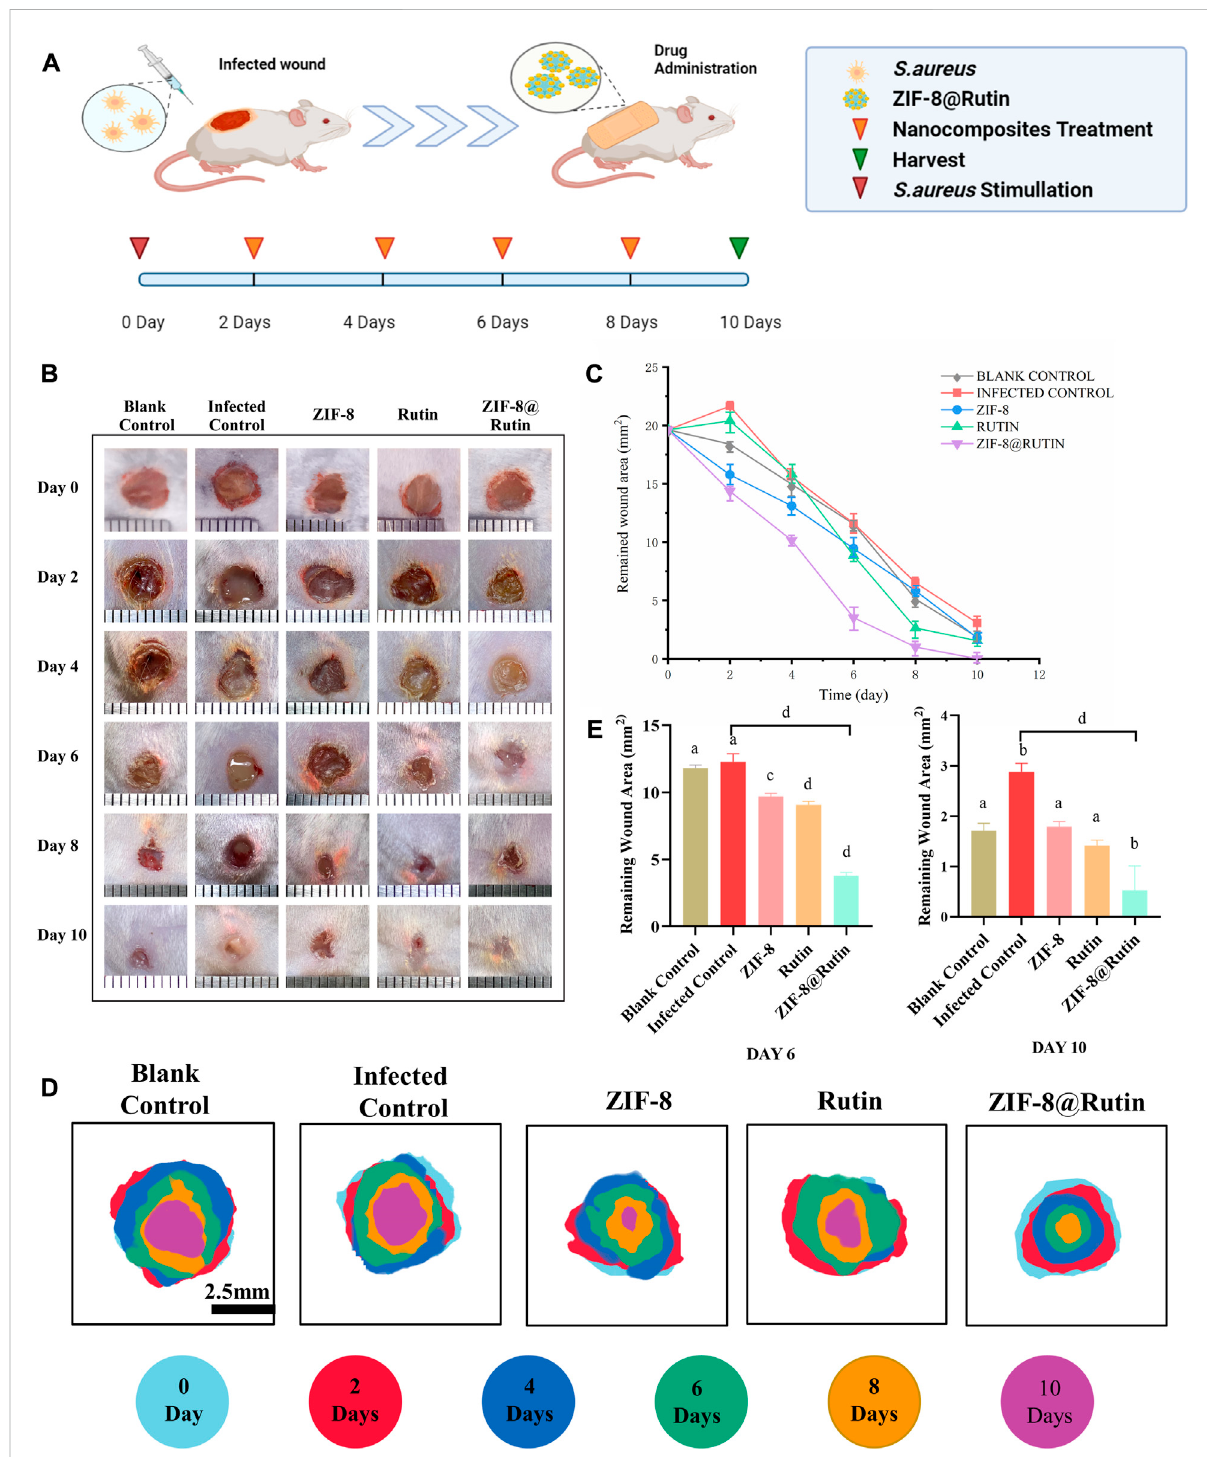
FIGURE 6 FacilitationoflocalizedinfectedwoundhealingbyZIF-8@RutinNPs invivo . (A) Schematicdiagramofthein fl ammationmodelonthedorsalskin of mice and the treatment process of ZIF-8@Rutin NPs. (B) Representative photographs of skin wounds at various stages of treatment with different dressingsand (C) relativewoundhealingremainingarea. (D) Schematicdiagramofwoundhealingprogressionatdifferenttimes.Blankcontrolswere added with the same amount of PBS only, and PBS without NPs was added to wounds stimulated by S. aureus as infection control. (E) The remainingareaofwoundhealingineachgroupondays6and10.(Valuesforblankgroupcalibratedto1. n =3;mean±sd;Ineachgraph,thevaluesof different letters differed signi fi cantly from each